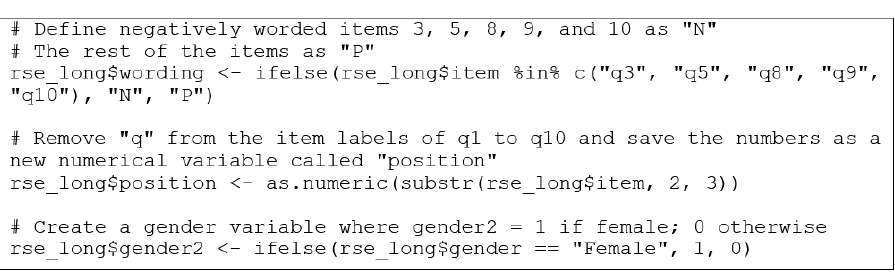
Figure 2. Creating item-level and person-level predictors.